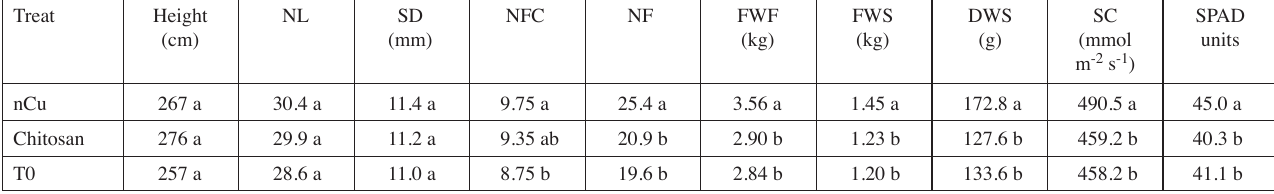
Treat: treatments. nCu: nCu-chitosan hydrogel. Chitosan: chitosan hydrogel without nCu. T0: absolute control without application of either chitosan hydrogel or nCu. NL: number of leaves. SD: stem diameter. NFC: number of floral clusters. NF: number of fruits. FWF: fresh weight of fruits. FWS: fresh weight of shoots. DWS: dry weight of shoot. SC: stomatal conductance. Data is the mean of 20 samples. Different letters by column indicate significant differences among treatments, at P ≤ 0.05, according to the LSD test.